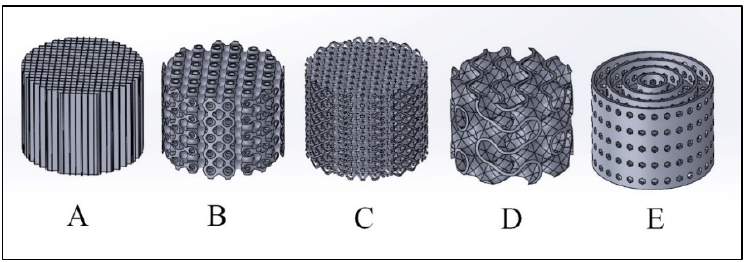
Figure 1. Scaffolds with: ( A ) Rectangular-, ( B ) Primitive-, ( C ) Lattice-, ( D ) Gyroid- and ( E ) Honeycomb-type structures (Dimensions: 20 mm in diameter and with 15 mm height), designed via computer-aided design (CAD) software.